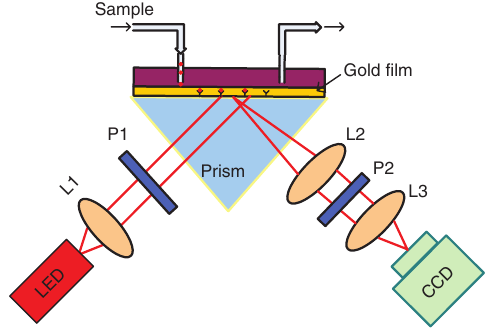
Figure 1: Schematic illustration of a typical prism-based intensity interrogation SPRi